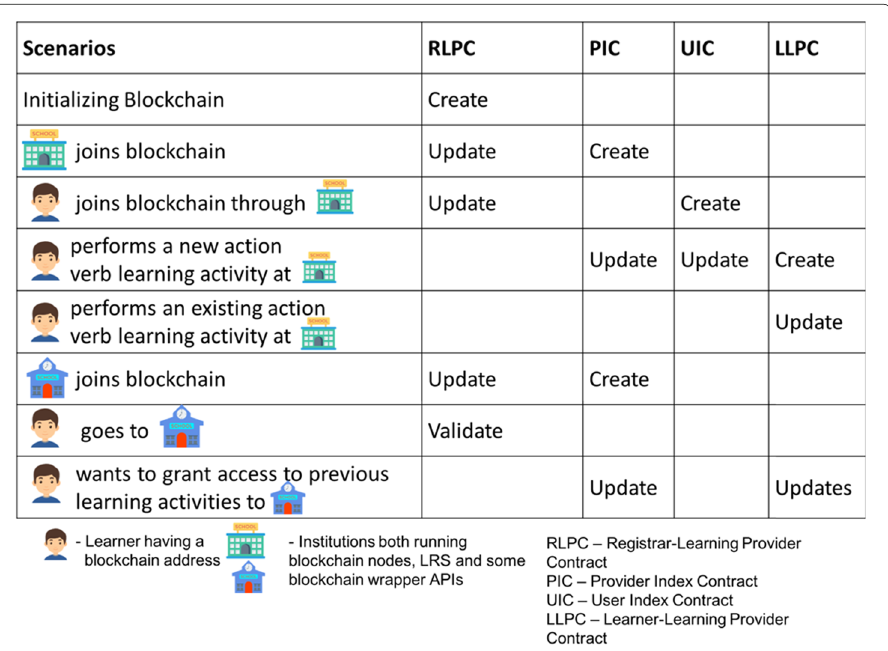
Fig. 5 Processes involved in enrolling or accessing information on BOLL. The different access/usage scenarios of the BOLL system are shown in this figure. We also show the consequent smart contracts that are affected by such operations and the type of changes